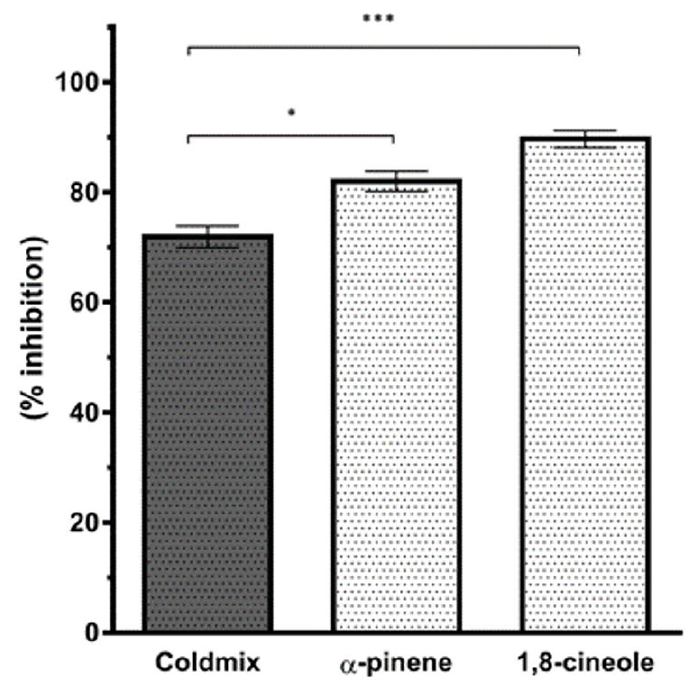
Figure 1. The in vitro ACE2 inhibition graph of Coldmix ® and major components, presenting the mean ± SD values ( n = 6). * p < 0.05 *** p < 0.001 determined by one-way ANOVA using Dunnet’s multiple comparison